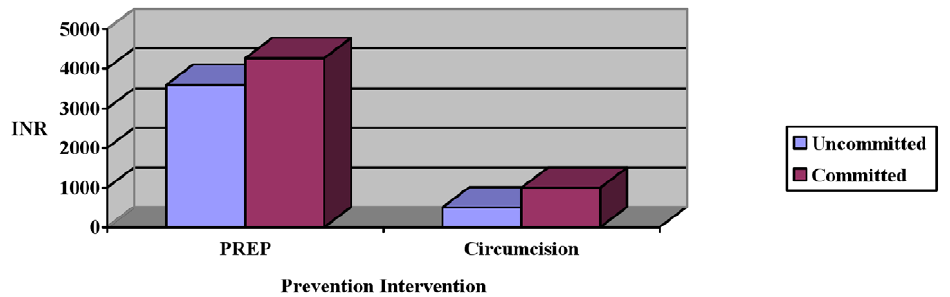
Figure 2. Willingness to pay for PREP and circumcision amongst those with and without initial commitment. a a Difference between committed and uncommitted willingness to pay for PREP and circumcision did not reach statistical significance by Wilcoxan Rank sum test.